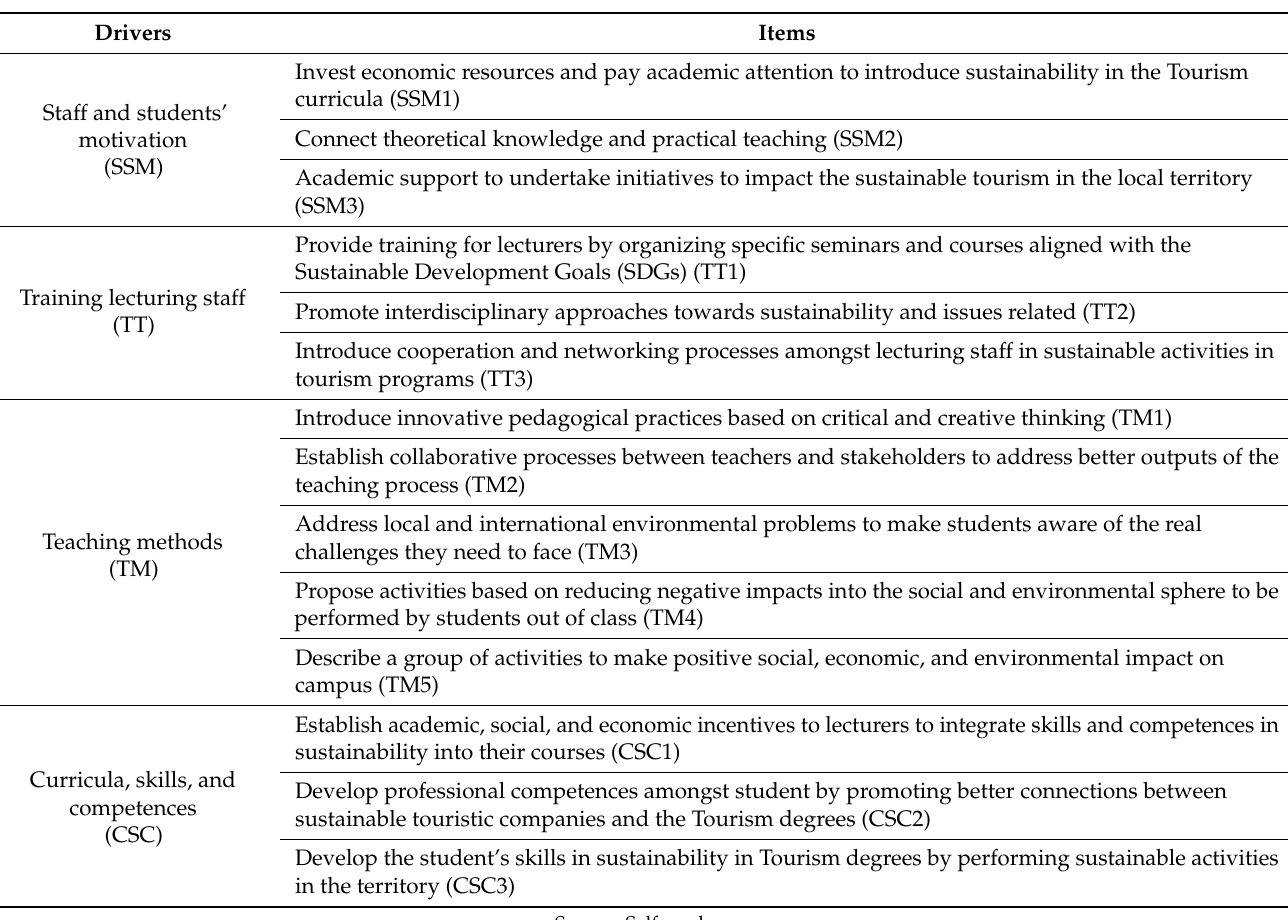
Table 6. Preliminary study and list of items corrected by